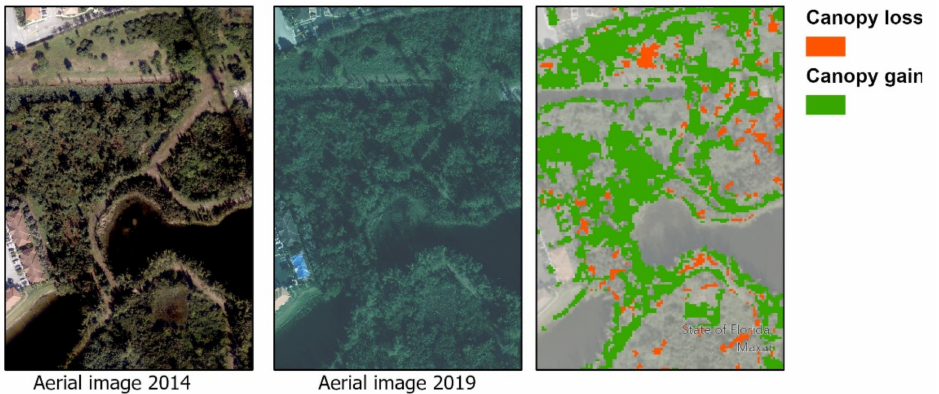
Figure 11. Canopy densification in a Miami Gardens natural area (background map credits: State of Florida,